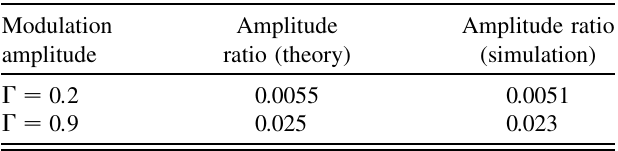
TABLE I. Comparison between the ratios of the fundamental and first spatial harmonics from theory and simulation.